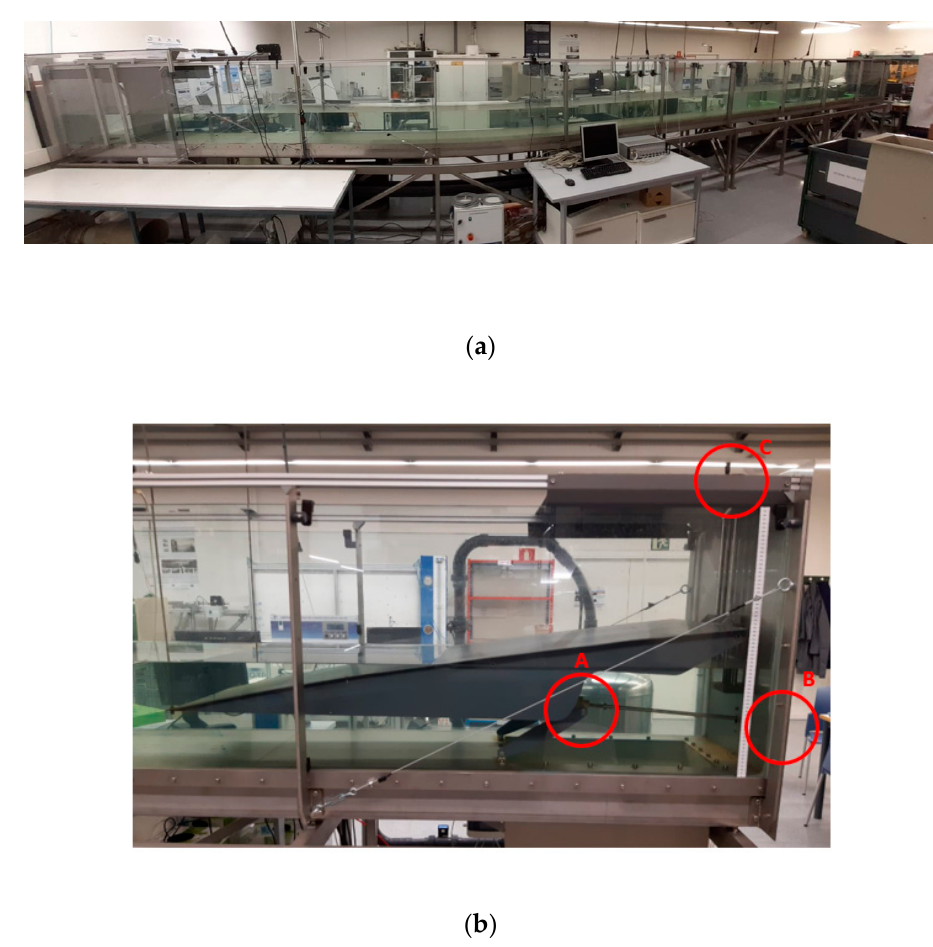
Figure 1. ( a ) The general view of the EWF from the piston-type wavemaker (left) to the extinction system (right). ( b ) Picture of the self-designed extinction system installed in the wave flume and the highlights of the join (A) and the position of the cranks (B and C) to modify the angle